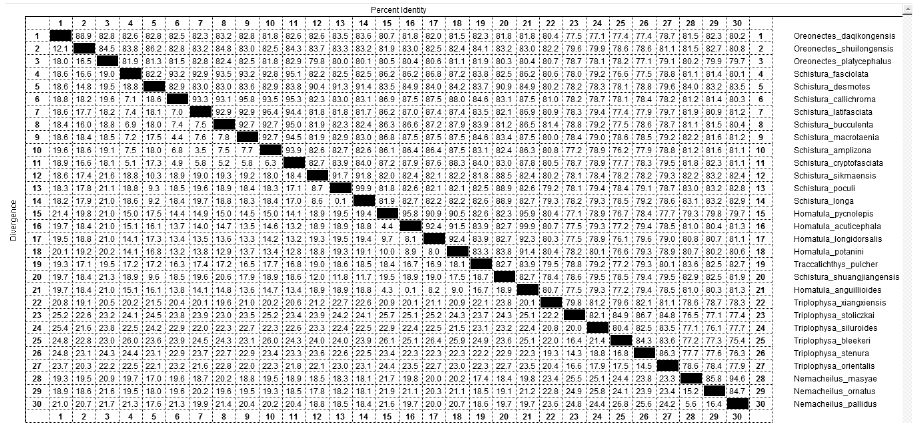
Figure 4. The sequence divergence of Cyt b between O. daqikongensis sp. n. and species of Nemacheilinae.